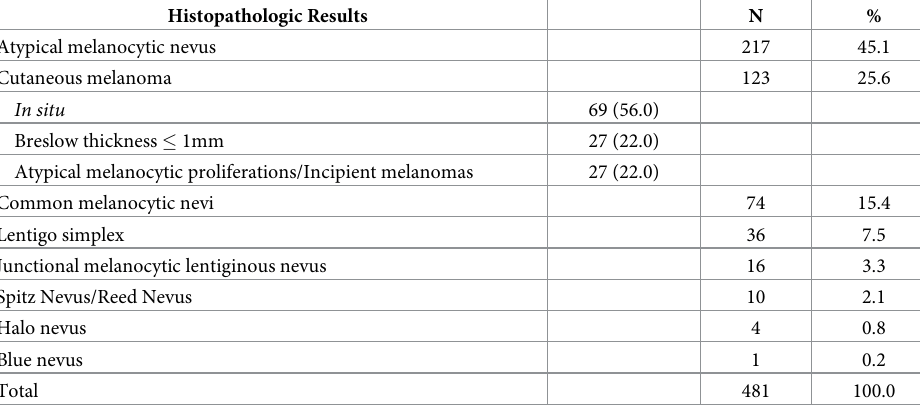
Table 1. Histopathological results of 481 lesions � 6mm in